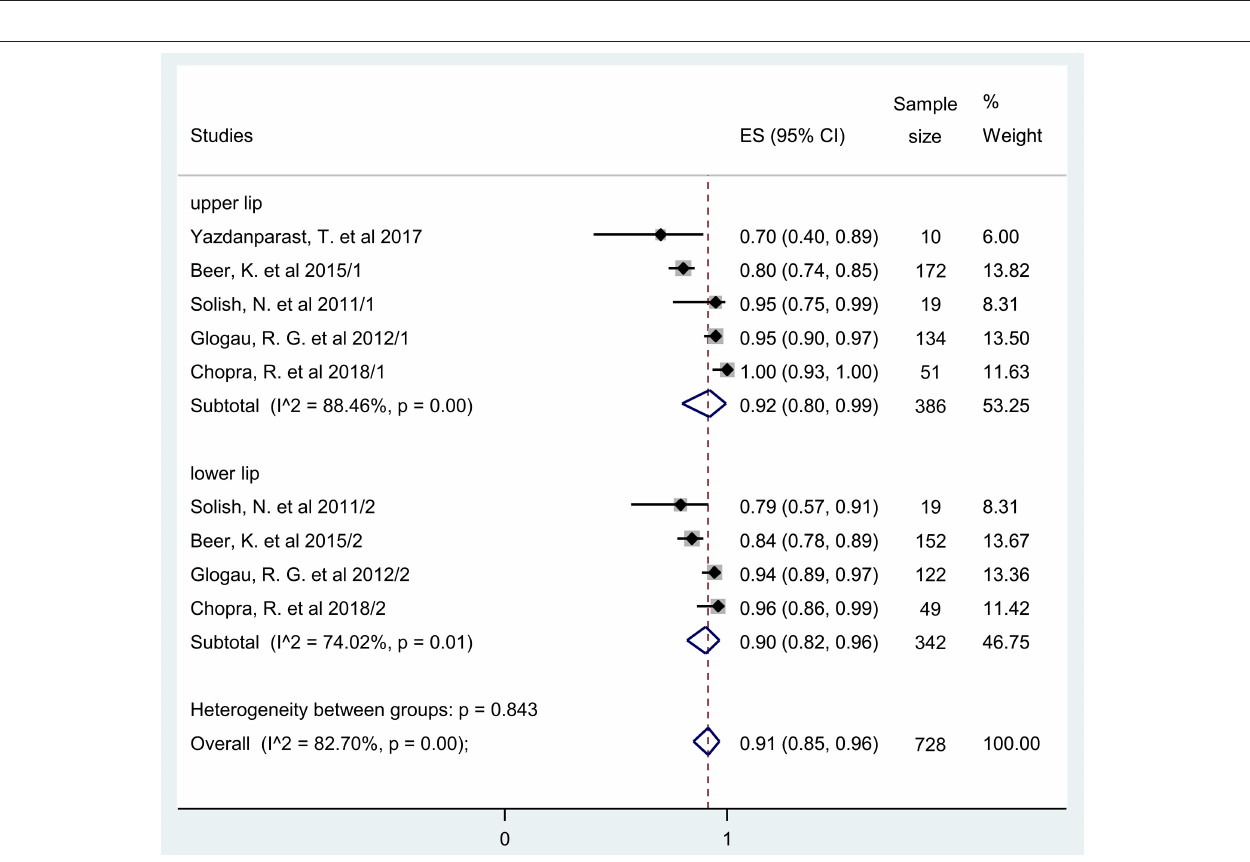
FIGURE 2 | Risk of bias graph. Representing the portion of bias in each domain.